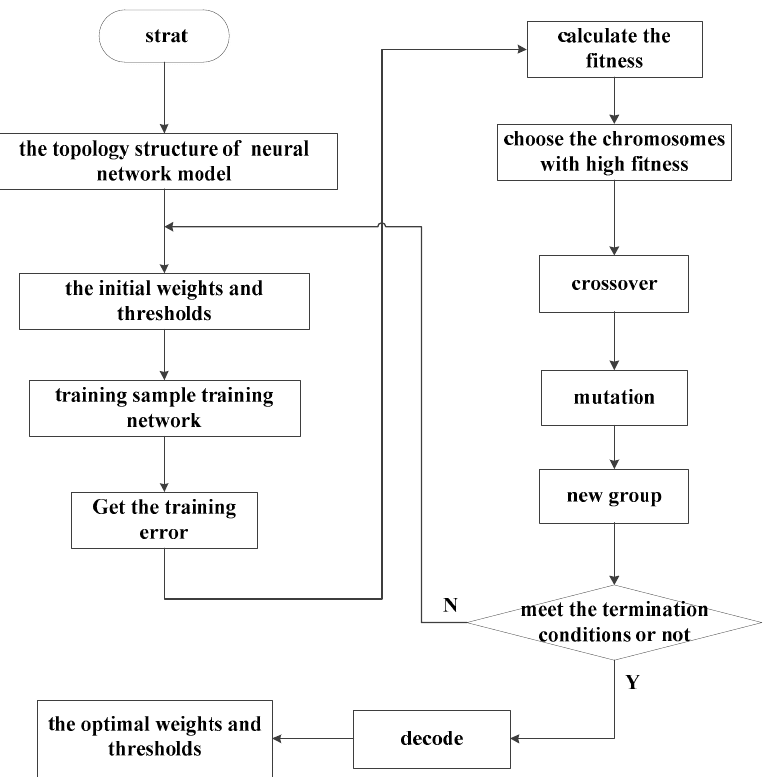
Figure 9. Flowchart of the improved original BP artificial neural network.